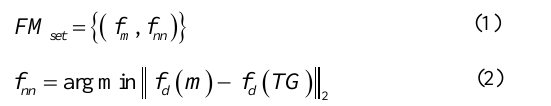
Fig.2 UAV image with GCPs of detritus dump, at Zijin Mine